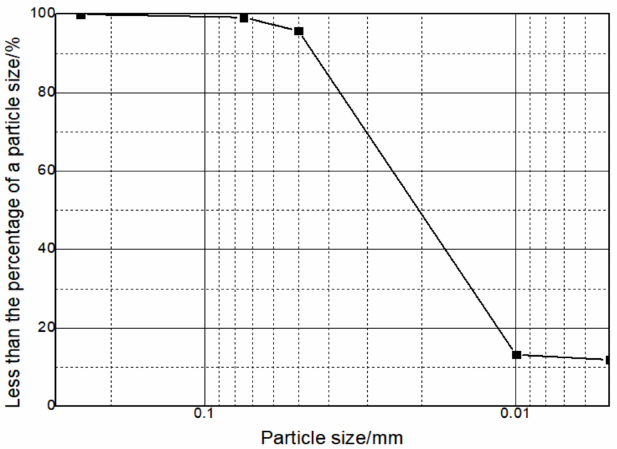
Figure 1. Particle size distribution curve of fly ash.